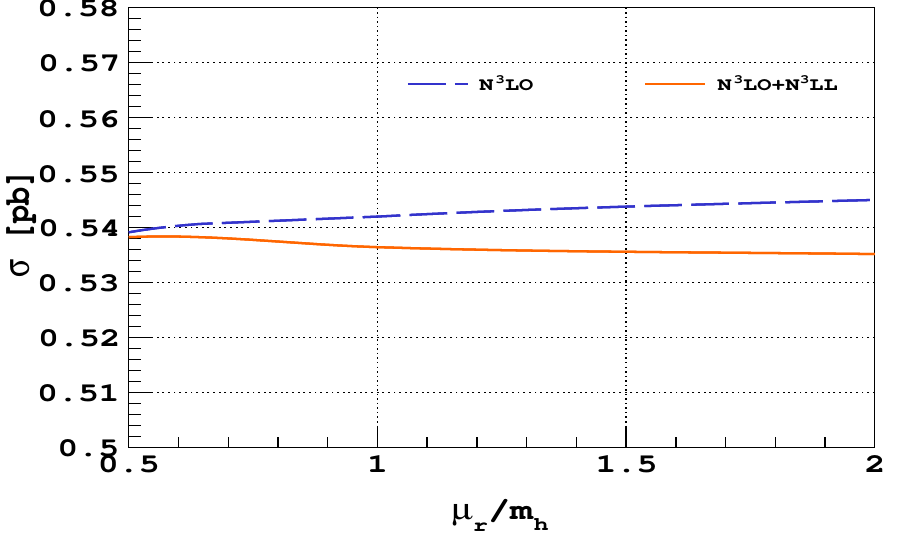
Figure 4 . Fixed order and resummed cross-sections are plotted at N 3 LO level against unphysical renormalization ( (cid:22) r ) scale varied in the range (1 = 2 ; 2) m h keeping factorization scale ( (cid:22) f ) (cid:12)xed at central value m h = 4. All the parameters are chosen same as in